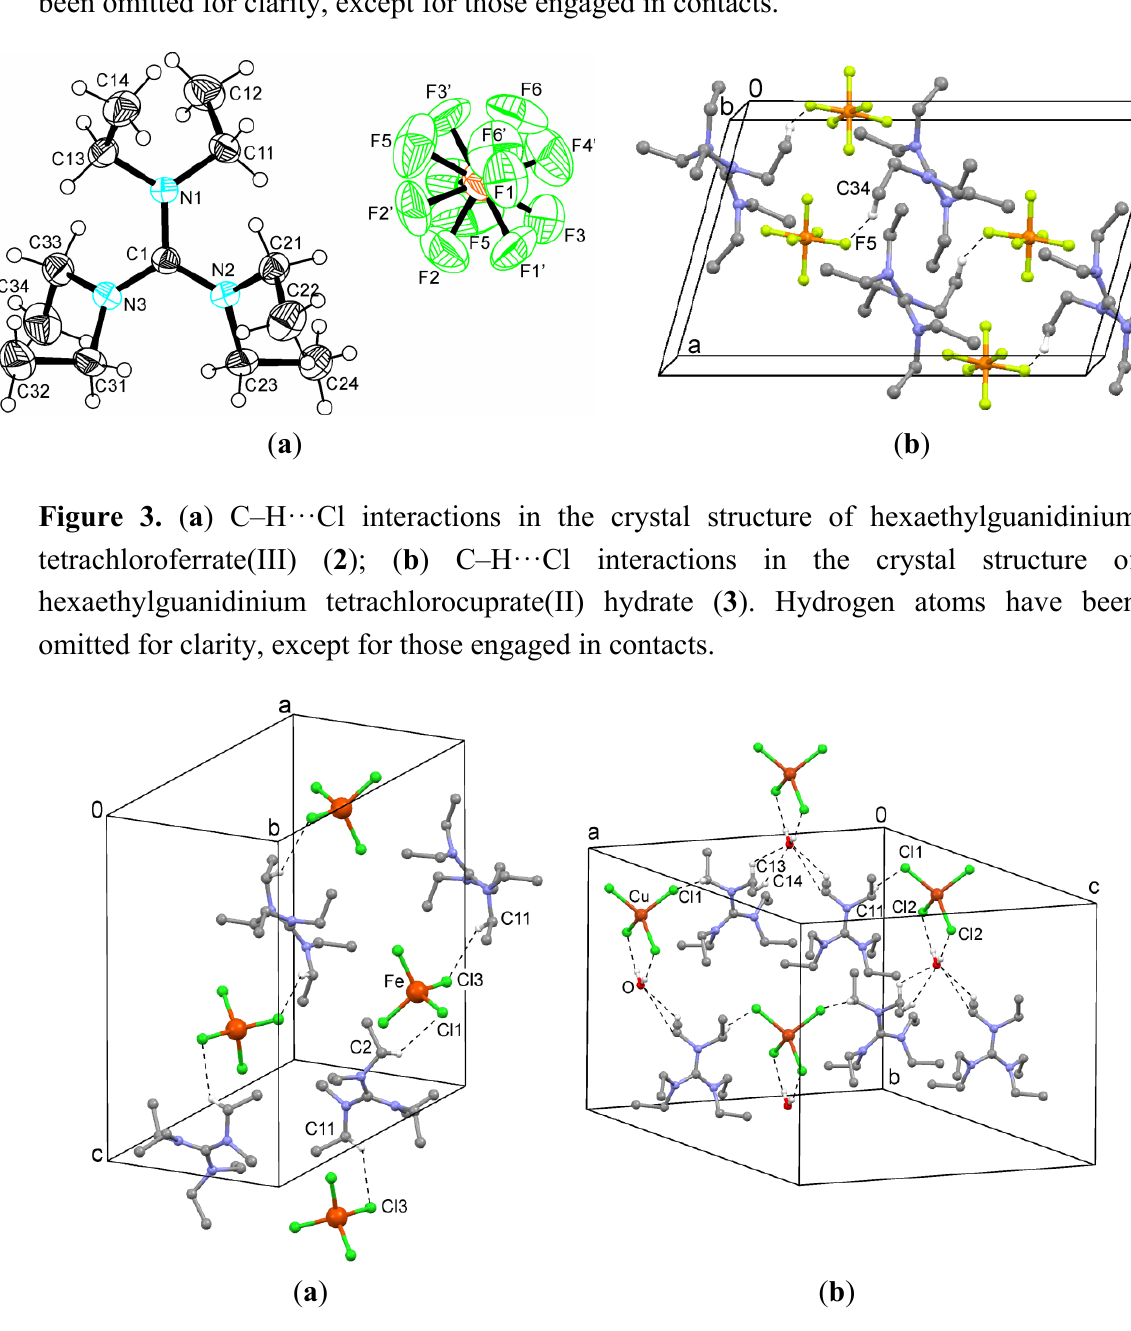
Figure 2. ( a ) Ionic structure of hexaethylguanidinium hexafluorophosphate ( 1 ) showing the disordered anion; ( b ) C–H ··· F interactions in the crystal structure of 1 . Hydrogen atoms have been omitted for clarity, except for those engaged in contacts.